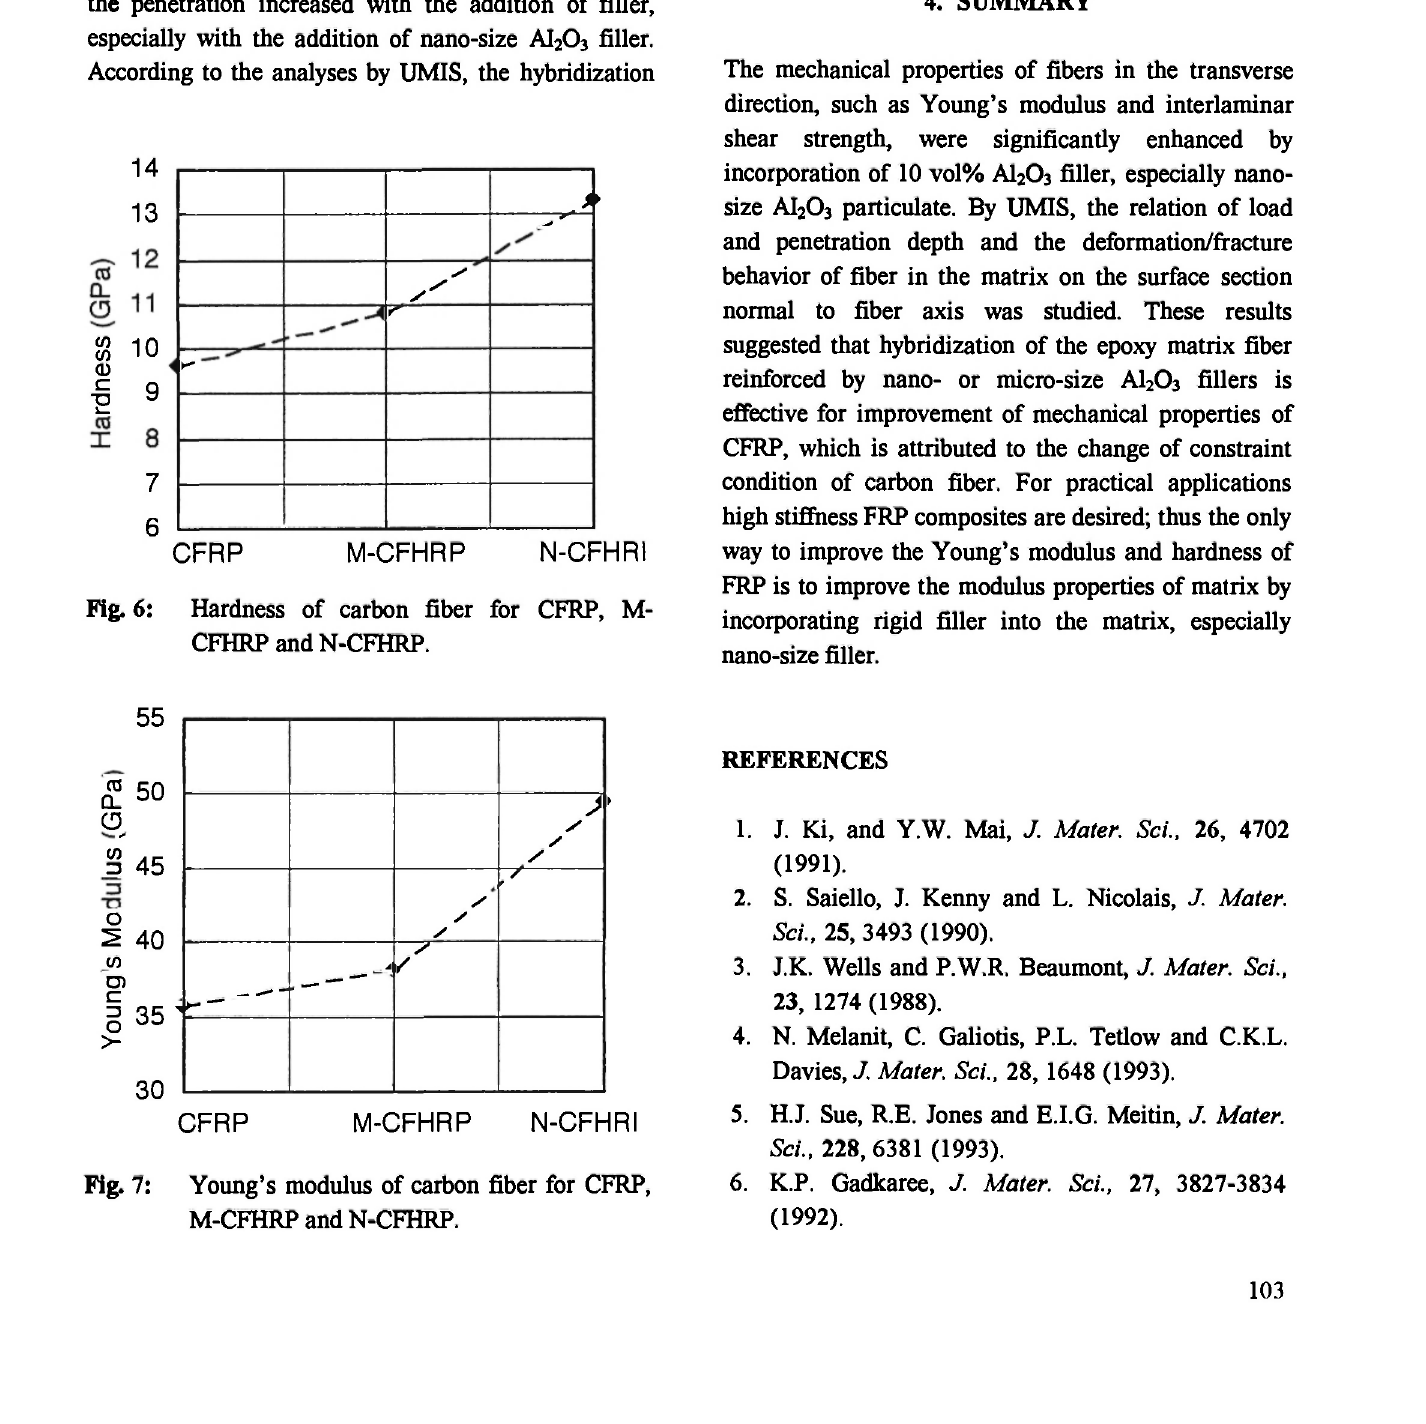
Fig. 7: Young's modulus of carbon fiber for CFRP, M-CFHRP and